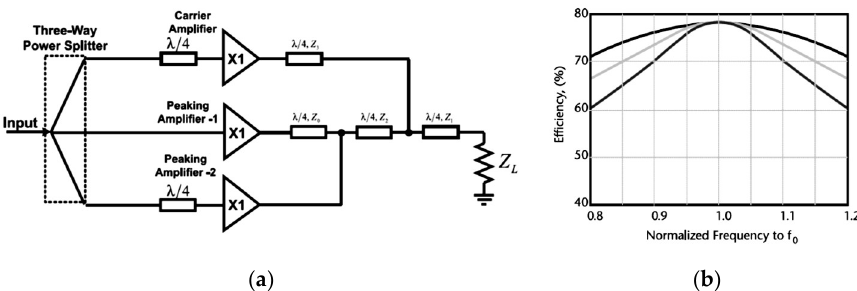
Figure 4. ( a ) Three-stage DPA architecture, ( b ) Efficiency versus frequency of improved three-stage